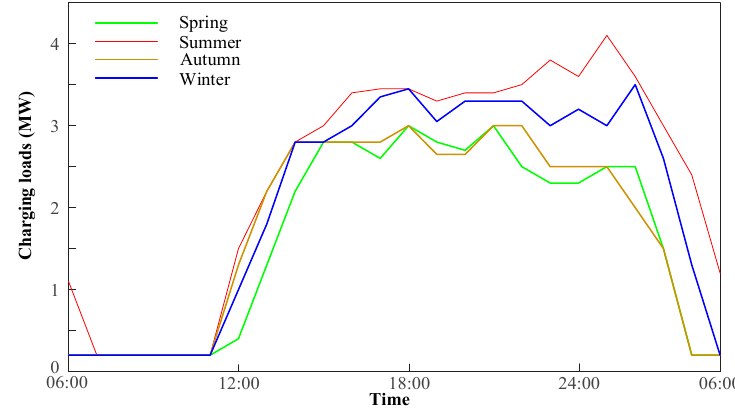
Figure 3. Average daily load curves of 2000 electric vehicles in different seasons [20]. Table 2. Standardized charging loads in different seasons.